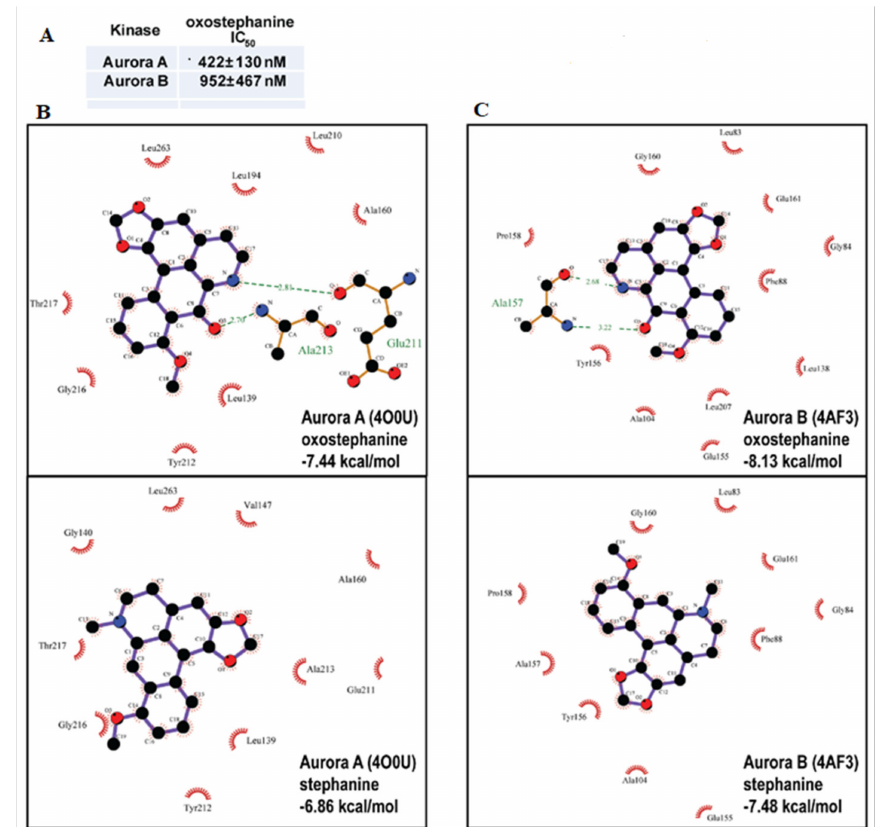
Figure 5. Oxostephanine ( 1 ) inhibits Aurora kinase activity, and is predicted to target the ATP binding pockets of Aurora kinases. ( A ) The IC 50 values of oxostephanine determined by an in vitro kinase assay are shown. Value is +/ − standard deviation, n = 2. ( B ) Oxostephanine is predicted to bind to the ATP binding pocket of Aurora kinases A. Two dimensional representations generated by LigPlot + are shown of the best binding energy poses of oxostephanine based on Autodock results. One-letter and three-letter codes are elements and amino acids, respectively. Green dashed lines denote H-bonds, and number is the distance in angstrom. Red half circles denote hydrophobic interactions. Predicted binding energy is indicated in blue. Aurora A is based on crystal structure 4O0U. ( C ) Oxostephanine is predicted to bind to the ATP binding pocket of Aurora kinase B. The representation is the same as above and Aurora B is based on crystal structure